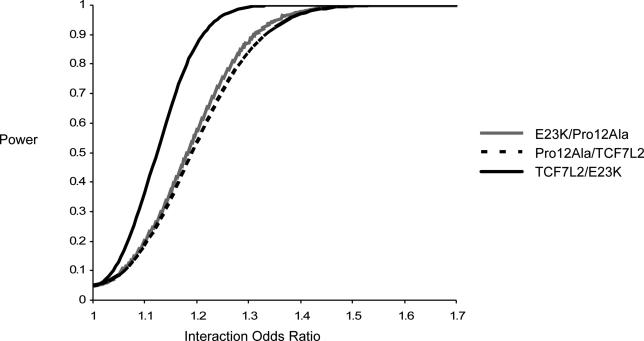
Power to Detect Interaction ORs for Combinations of SNPsThe power calculations assume a multiplicative mode of inheritance. Estimates of allele frequencies and expected effect size were determined from the literature; our study frequencies and effects sizes are consistent with these. α was set at 0.05. The power calculations were performed using Quanto [22].